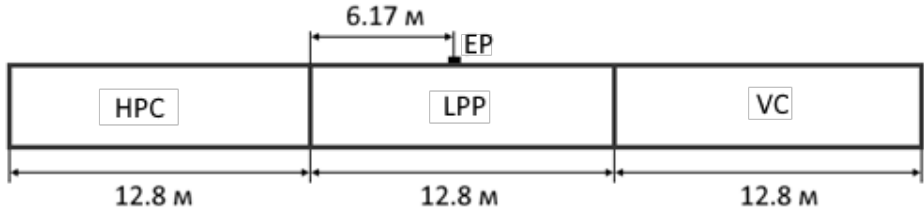
Figure 7. Geometrical parameters of the computational region.